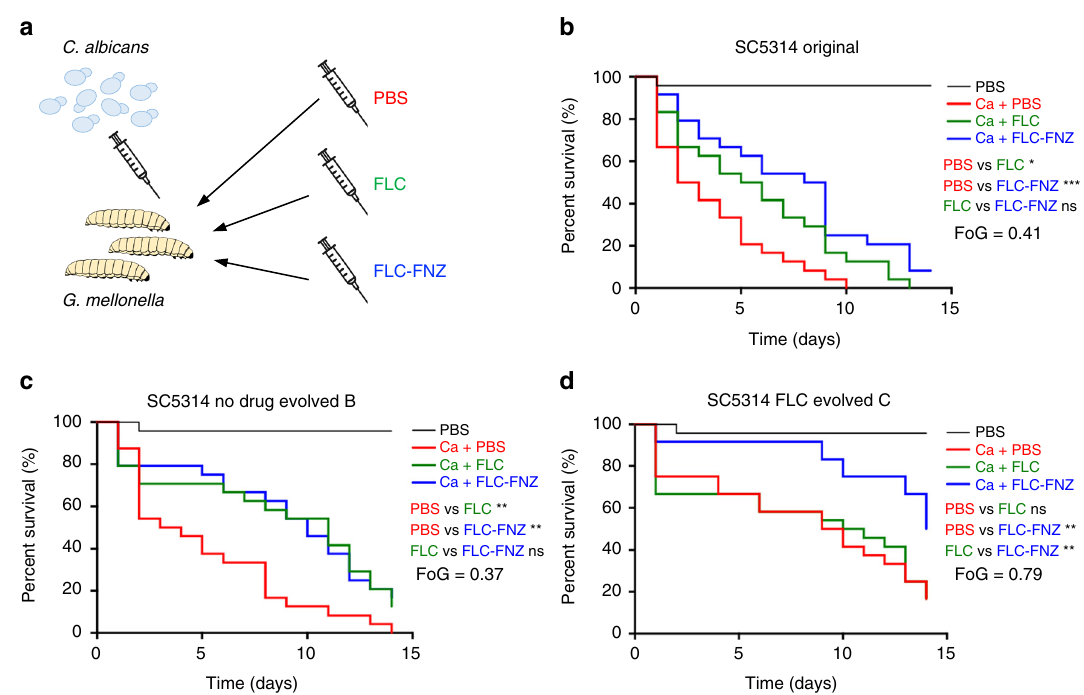
Fig. 5 Combination therapy partially rescues systemic infection of G. mellonella by high FoG C. albicans isolates. a G. mellonella larvae were injected with 3 × 10 5 yeast cells/larvae followed by a second injection with either PBS, FLC alone, or FLC and FNZ within 90 min of the fi rst injection. b – d Survival curves of larvae infected with SC5314 ( b ), low FoG ( c ) and high FoG ( d ) isogenic derivatives. Each curve represents a group of 24 larvae ( n = 24) which were monitored daily for survival for up to 14 days after infection. P values represent results of log-rank test comparing different treatment conditions with signi fi cance values as follows: *** P < 0.001; ** P < 0.01; * P < 0.05; ns nonsigni fi